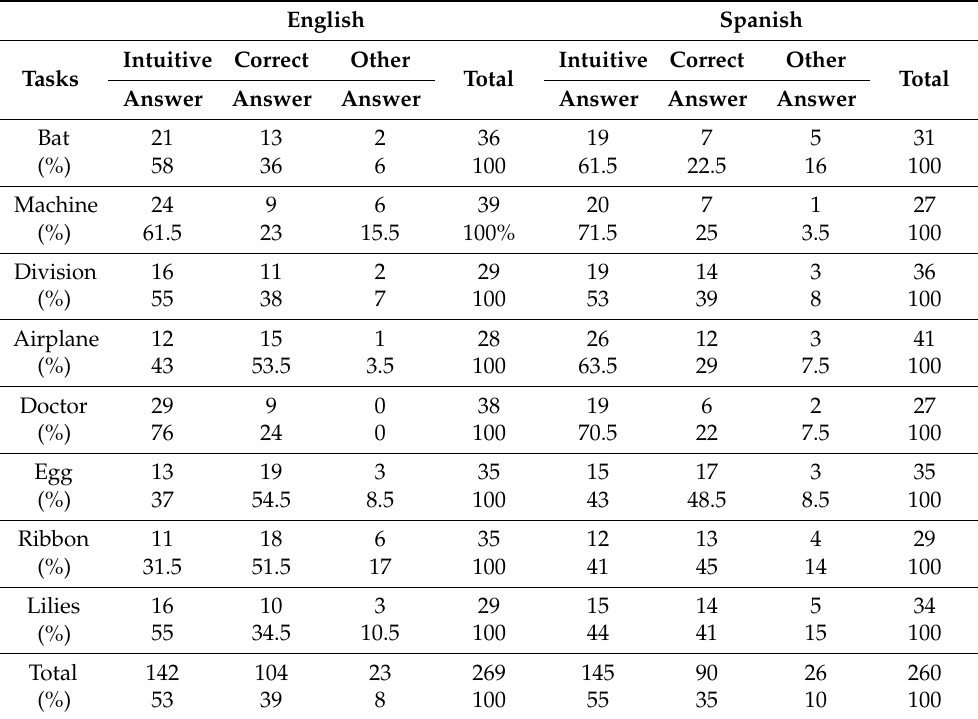
Table 13. Cognitive Reflection Test results (total count and percentages per answer type per language for each